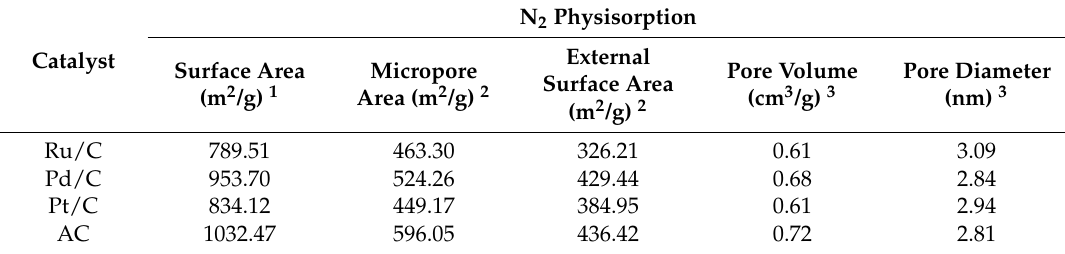
Table 1. Physical properties of the catalysts.